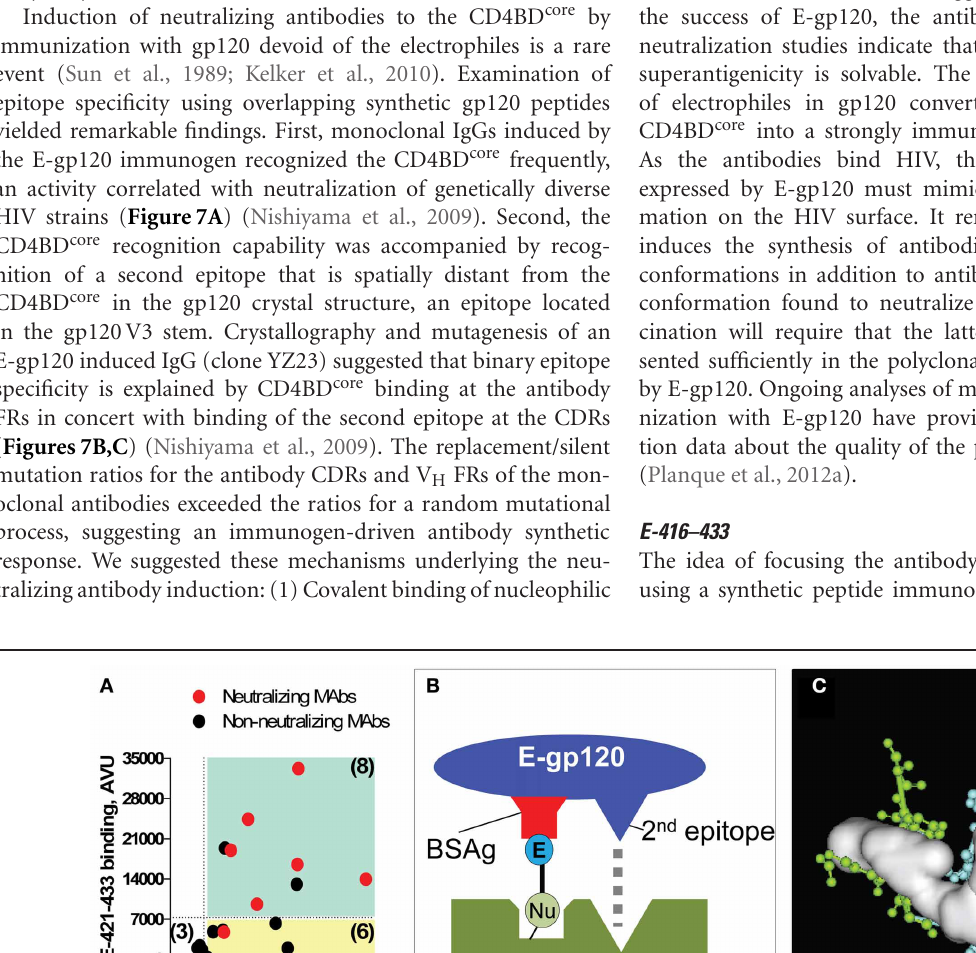
MAbs. Number in parentheses corresponds to the MAbs in the quadrant. (B) Binary epitope BCR-immunogen recognition model. E-gp120 binds BCR nucleophiles (Nu)covalently, releasing alarge amount of energy that eliminates the physiological restriction on differentiation of innate CD4BD core -specific B cells. Concomitant CDR binding by the 2nd E-gp120 epitope also counteracts negative B cell signaling. (C) Expanded view of V H FR-cavity fitted with the solid white object deduced by crystallography. Cyan, V H FR residues; green, V H CDR2 residues. Yellow line connects atoms that can form a nucleophilic diad by serving as the proton donor–acceptor pair (V H T70 O γ ; V H T70 carbonyl O). Panels (A) and (C) from reference Nishiyama et al.